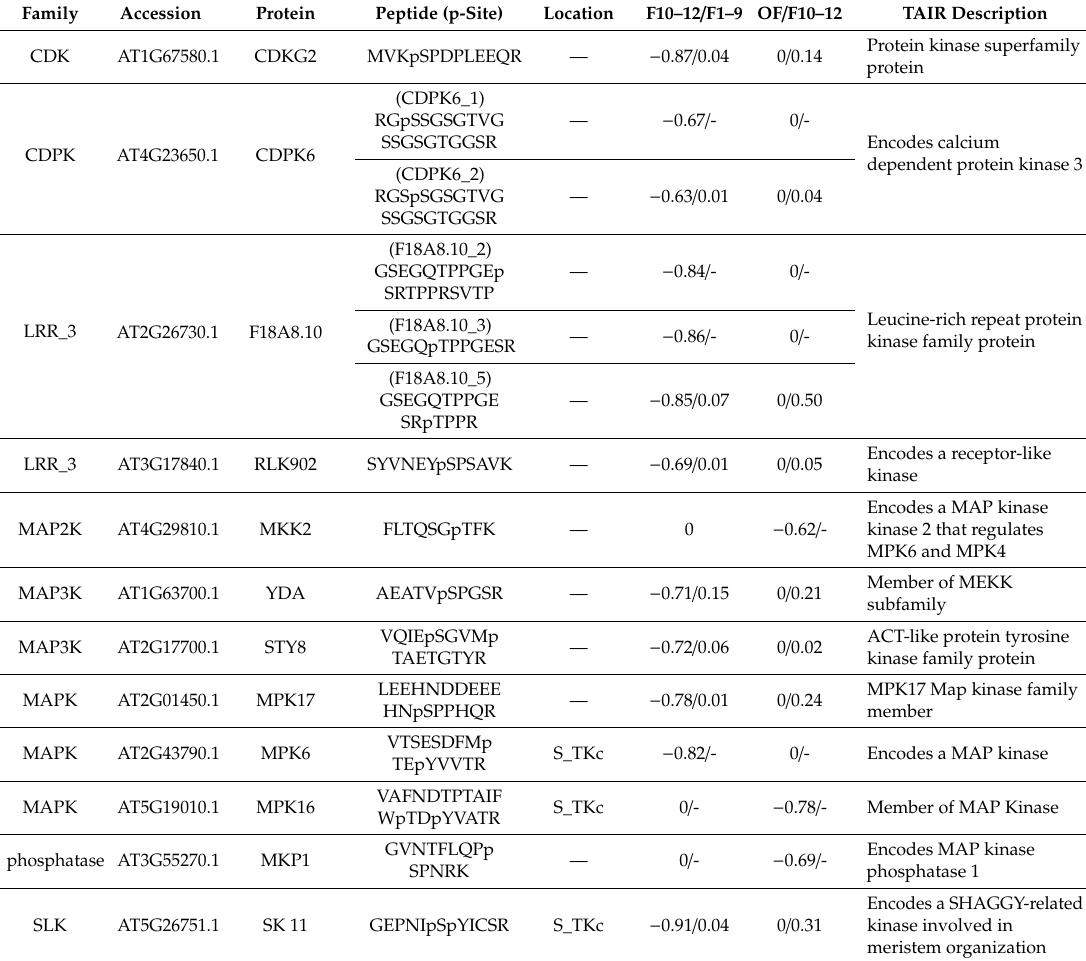
Table 4. Phosphorylation sites of kinases and phosphatases showing di ff erent phosphorylation levels in the comparison of F10–12 to F1–9 and OF to